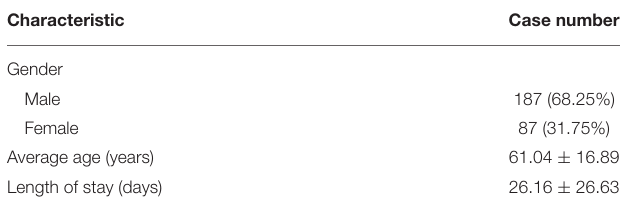
TABLE 1 | Demographic data of patients with deep fungal infections.